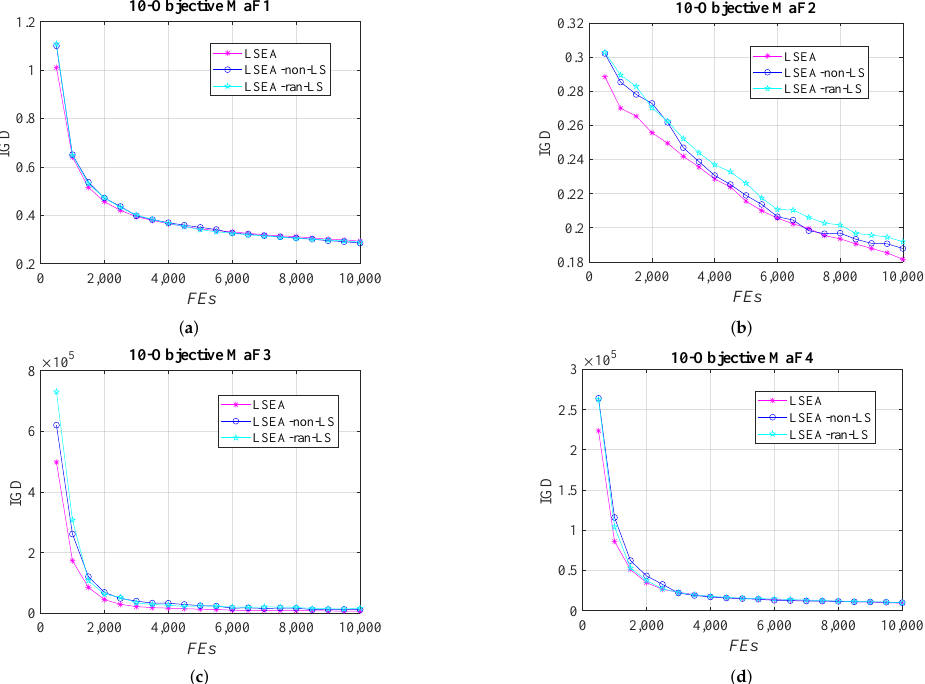
Figure 5. Changes in the IGD values of LSEA, LSEA-non-LS, and LSEA-ran-LS, where FEs denotes the number of function evaluations. ( a ) on 10-objective MaF1, ( b ) on 10-objective MaF2, ( c ) on 10-objective MaF3, ( d ) on 10-objective